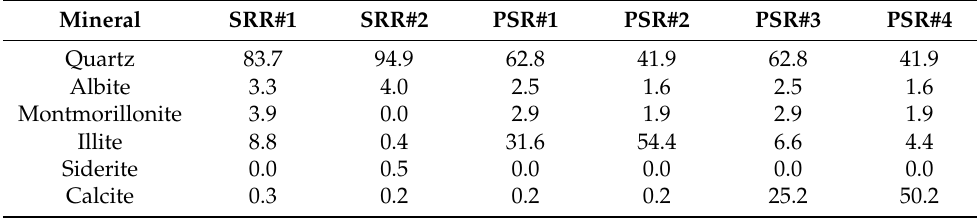
Table 1. Mineralogical compositions (weight percent) of the sandstone rocks and the mineral mixtures.